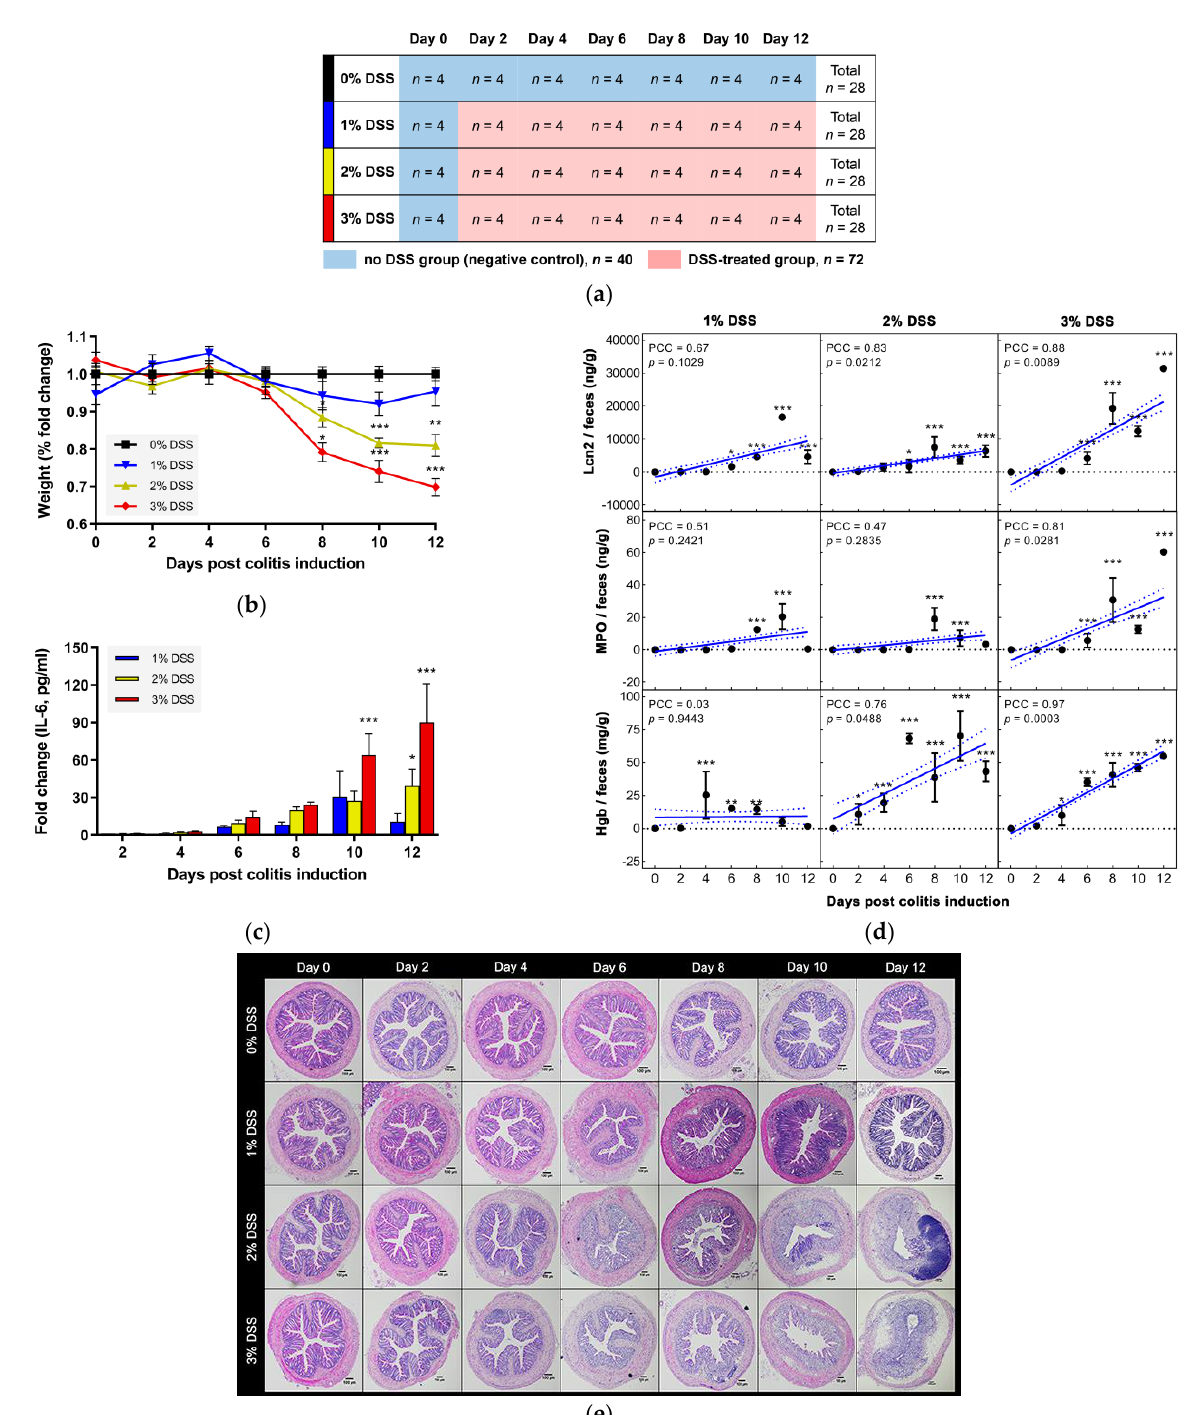
Figure 1. Experimental design and pathological/pathophysiological changes. ( a ) The in vivo experimental scheme. Four mice from each dextran sulfate sodium (DSS) group (total n = 28 per group) were sacrificed at two-day intervals. Shown in red is the negative control consisting of the 0% DSS group and the initial mice of all DSS groups. ( b ) Fold change in body weight (%) compared to that of the 0% DSS group. ( c ) Fold change in serum IL-6 level compared to that of the negative control. ( d ) Fecal inflammatory biomarkers. ( e ) Histological architecture of distal colon tissue in DSS-induced colitis mice. Original magnification, 4×. Scale bars, 100 µm. Significance is indicated compared to the 0% DSS group values. Correlations with treatment duration and significance are indicated as PCC and p value. All data represent the mean ± SEM. Statistical significance is indicated as follows: * p < 0.05, ** p < 0.01, and *** p < 0.001.